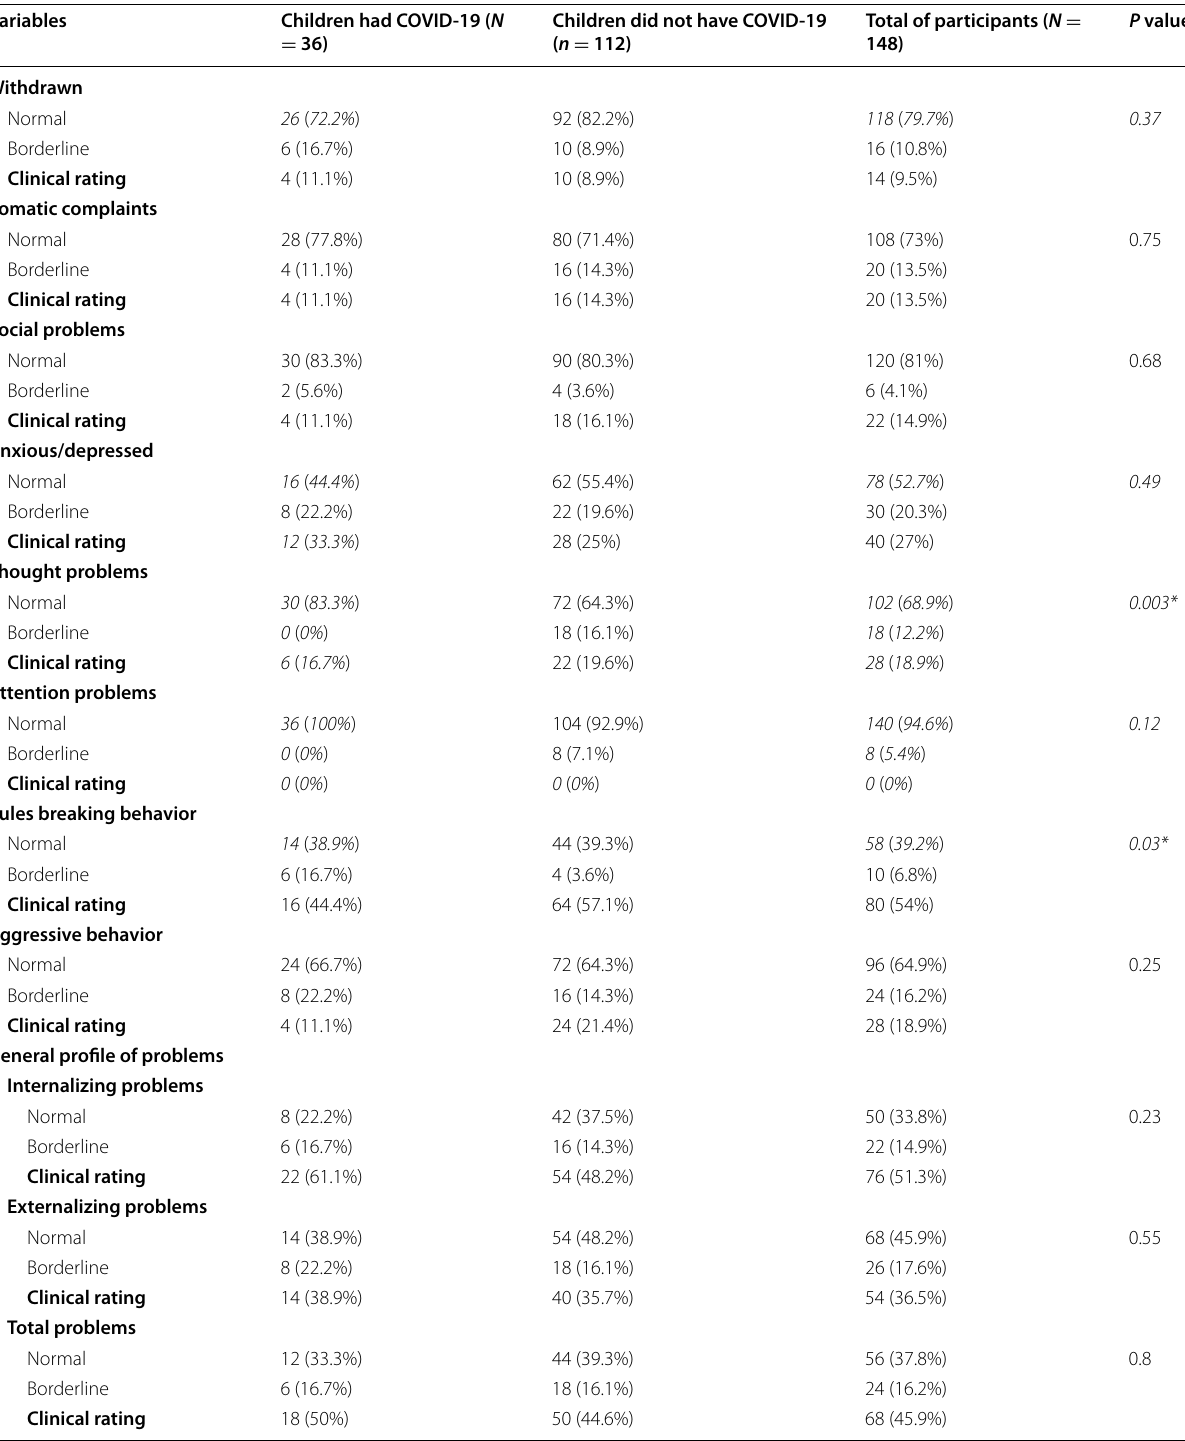
Table 3 CBCL Profile of syndromes of studied